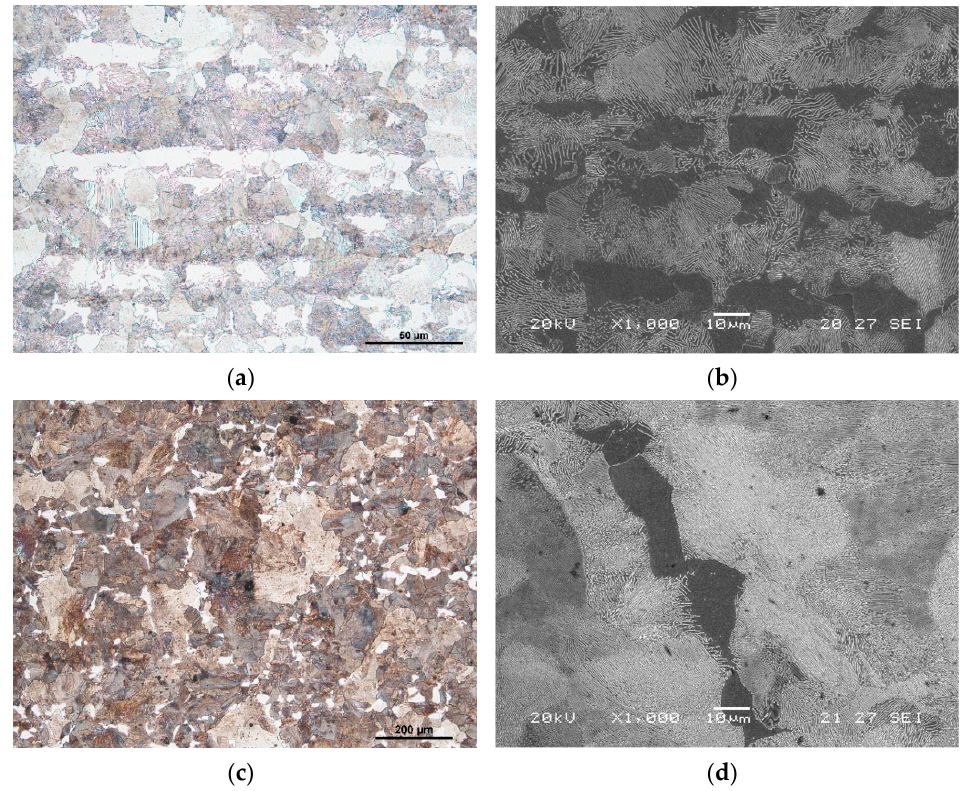
Figure 4. Microstructures of annealed 42CrMo4 steel: FC-845, ( a ) optical micrograph and ( b ) SEM micrograph; FC-1050, ( c ) optical micrograph and ( d ) SEM micrograph. Table 4. Chemical composition (weight %) of the 42CrMo4 steel used in this